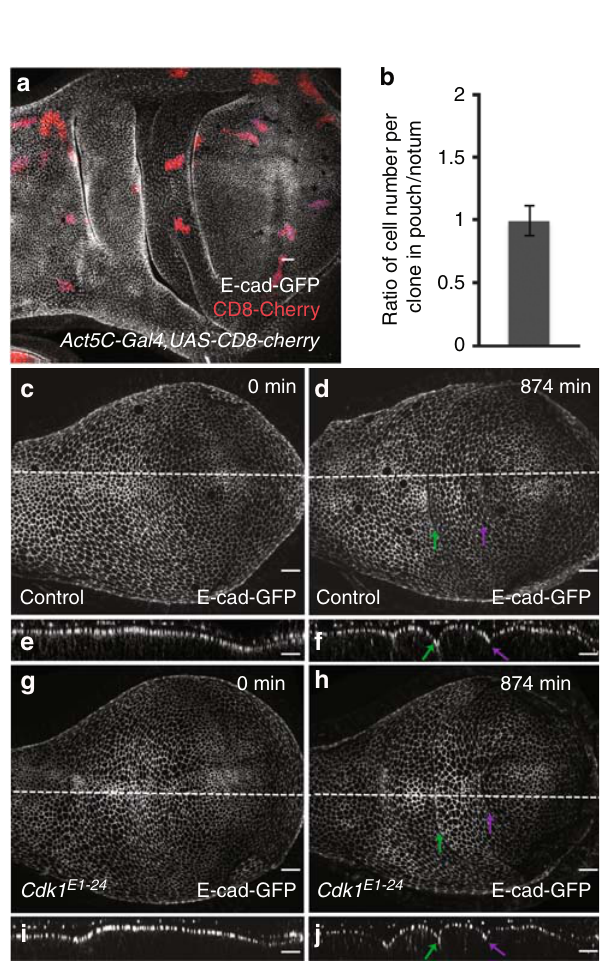
Fig. 2 Cell proliferation and the role of cell division for epithelial folding. a A wing imaginal disc of a 96 h after egg lay (AEL) larva carrying 48 h-old clones of cells marked by the expression of CD8-mCherry ( Act5C > Gal4 , UAS-CD8-mCherry , red). Adherens junctions are labeled by E-cad-GFP (gray). Scale bar is 10 μ m. b Ratio of the average cell number per clone in the pouch and the average cell number per clone in the notum. Mean and s. e.m. are shown. n = 19 wing imaginal discs, 82 clones in the pouch region, and 59 clones in the notum region. c – j Top view ( c , d , g , h ) and cross- sectional ( e , f , i , j ) images of time-lapse movies of control ( c – f ) and Cdk1 E1- 24 mutant ( g – j ) cultured wing imaginal discs expressing E-cad-GFP are shown for the indicated time points after shift to the restrictive temperature. Scale bars are 10 μ m